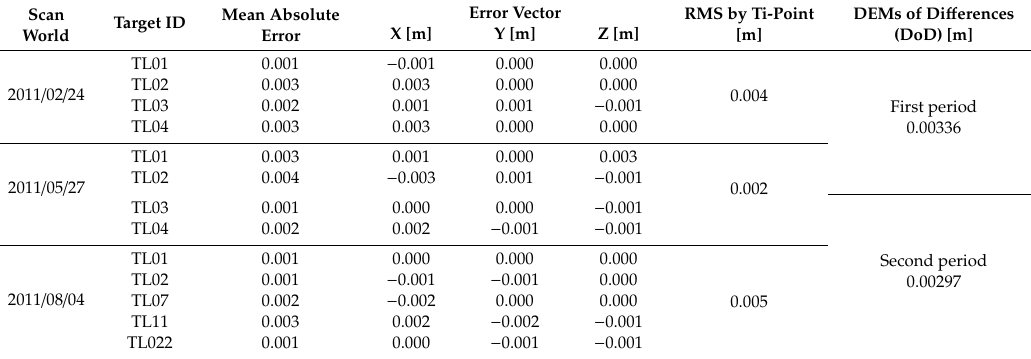
Table 2. Registration errors of 2011